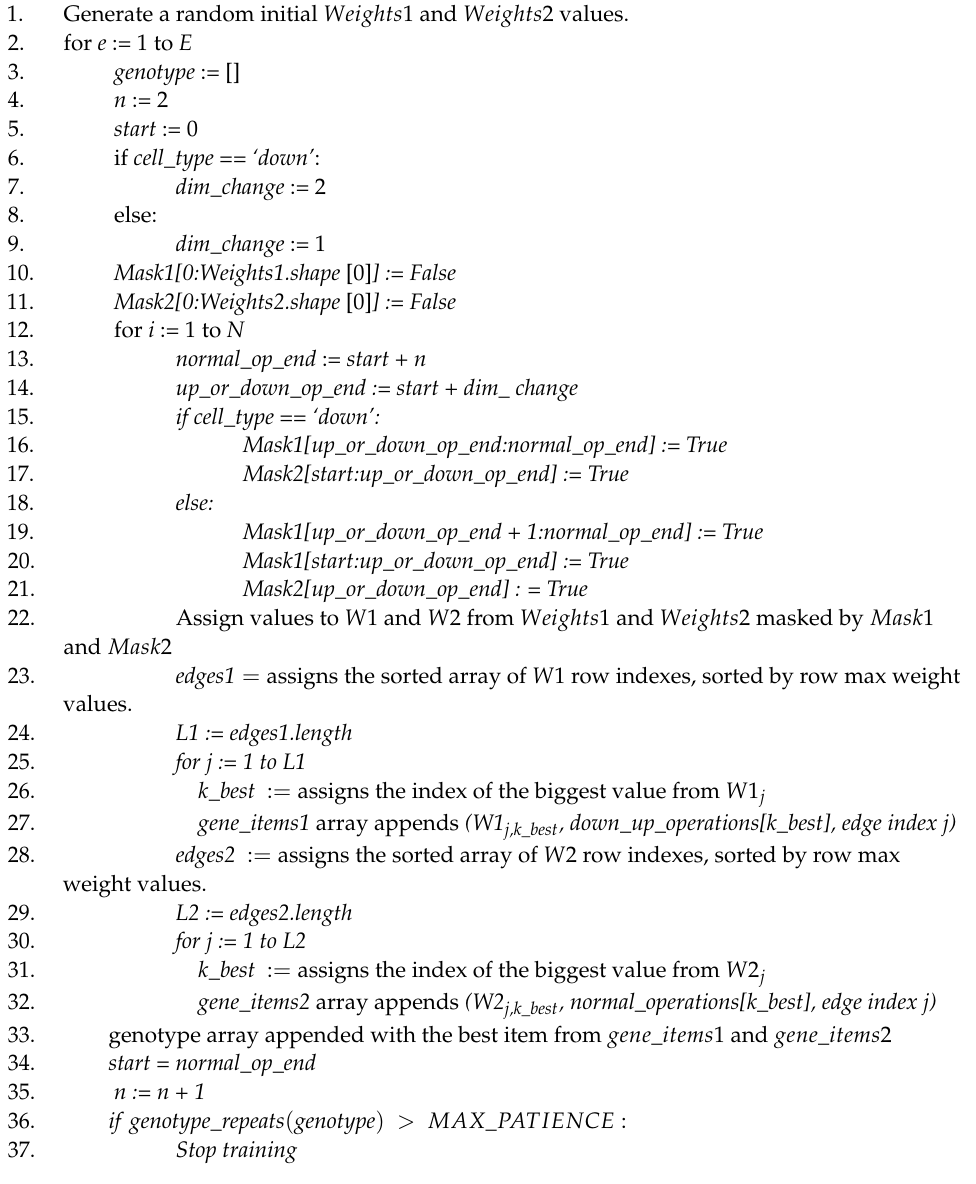
Algorithm 1. Nas-macu cell genotype